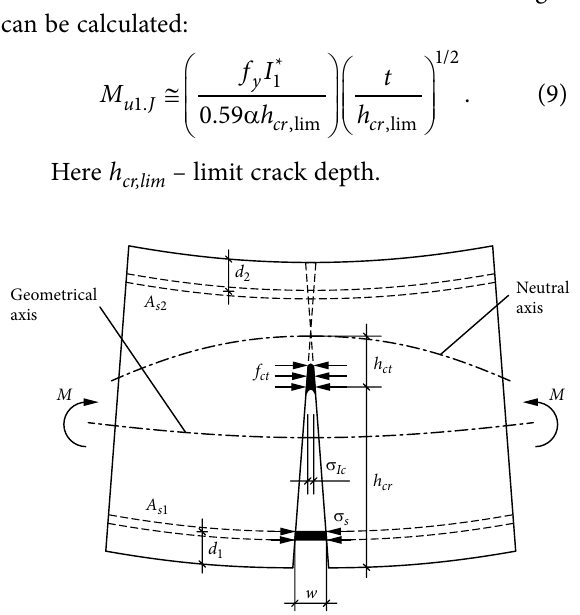
Fig. 3. The model for calculation of normal crack development (Jokūbaitis, Juknevičius 2013)